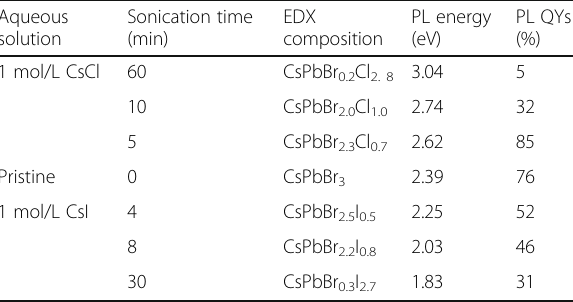
Table 1 Composition, emission energy, and PLQY of CsPbBr 3 NCs exchanged under different conditions Aqueous solution